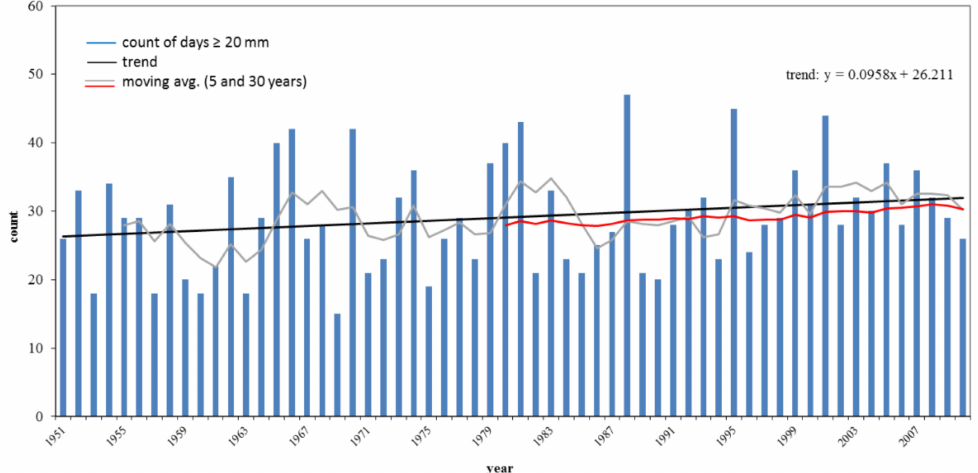
Figure 10. Frequency of rainfall days with ≥ 20 mm and trend at station Zugspitze (1951–2012, similar to Figure